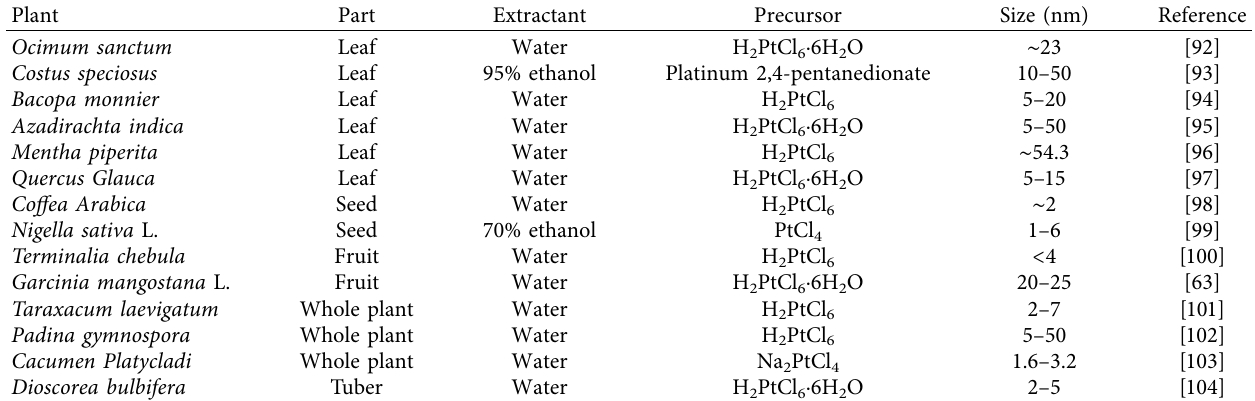
Table 4: Representative examples for the use of plant extracts for PtNP